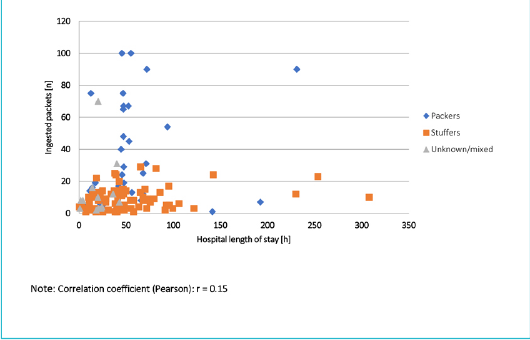
Figure 2: Length of stay (hours) in relation to calculated number of packages on computed